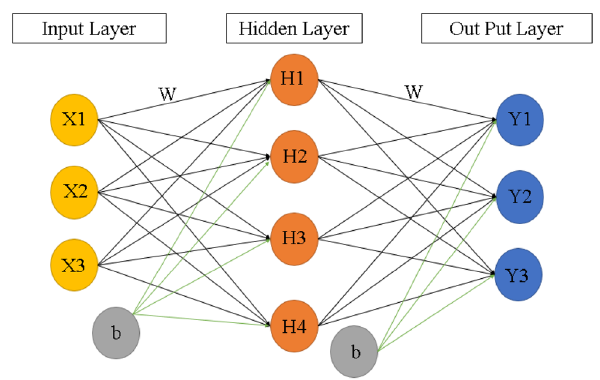
Fig. 4 Artificial neural network